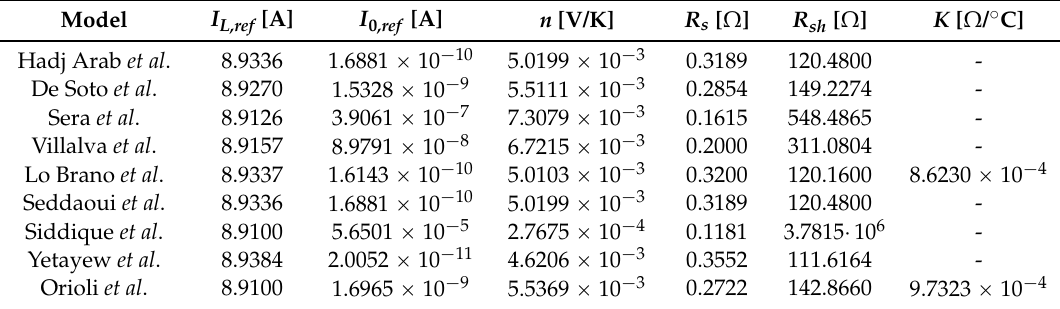
Table 3. Model parameters of Kyocera KD245GH-4FB2 at the SRC.